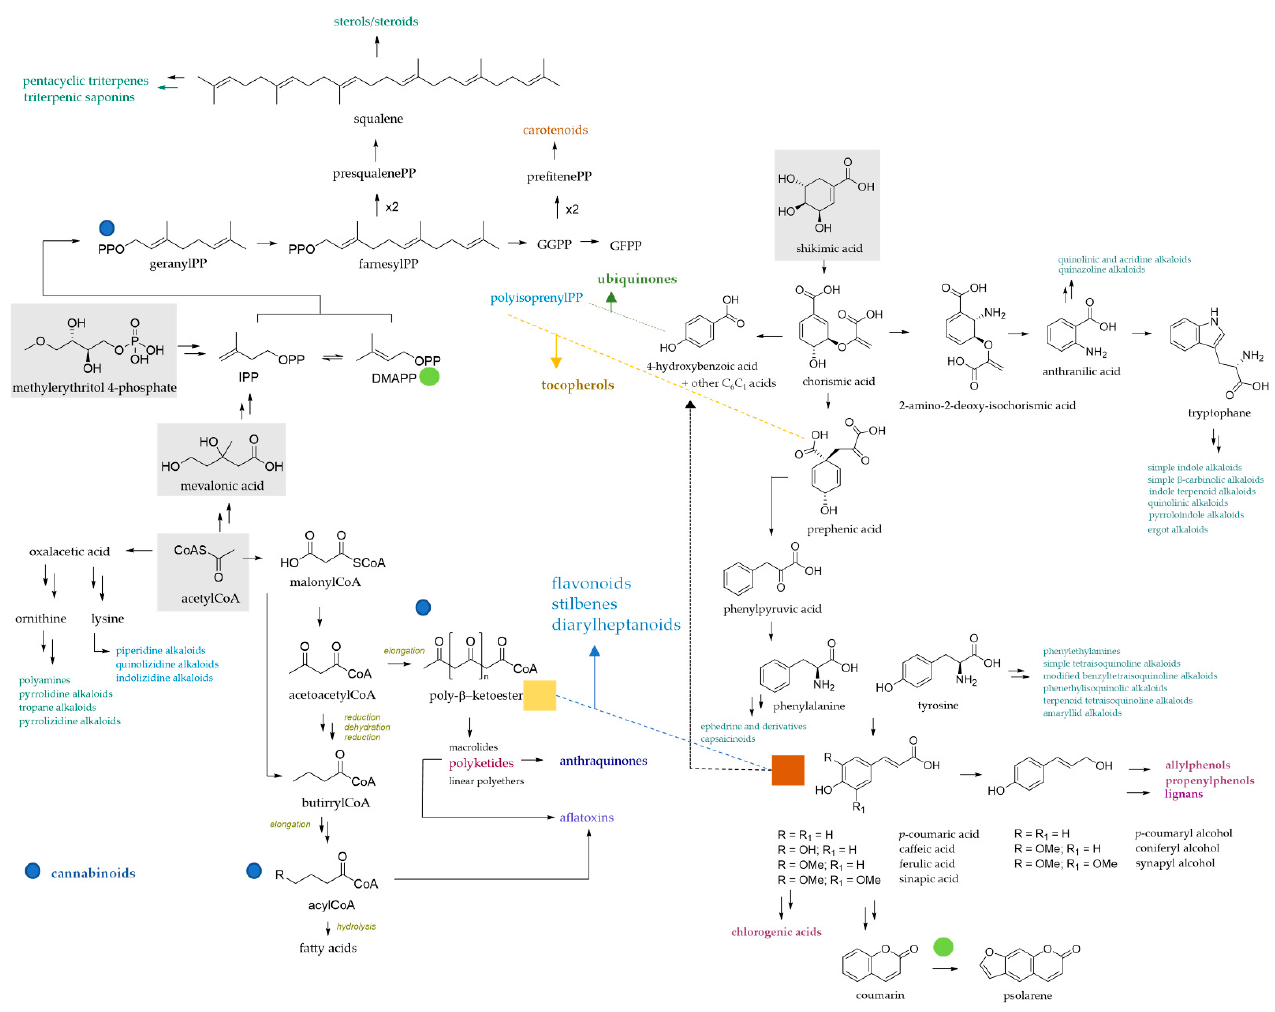
Figure 1. Schematic of the main biosynthetic pathways in plants to achieve phenols and polyphenols. Shikimic acid is the precursor of simple phenols and phenylpropanoids (hydroxycinnamic acid, coumarin lignans and lignins), which upon reacting with polyketides by acetate/malonate pathway favours the synthesis of flavonoids, stilbenes, flavolignans, and structurally related compounds. Terpenoid quinones are also produced when shikimic acid derivatives react with polyisoprenyl chains. The acetate pathway leads to fatty acid biosynthesis, by FAS enzyme, or poly- β -keto chains, which upon undergoing intramolecular reaction by polyketide synthase, leads to simple phenols, generally characterized by meta -substitution, or more complex compounds such as anthraquinones and aflatoxins. Three units of acetyl CoA combined by Claisen and aldol reactions lead to mevalonic acid, from which isopentenyl pyrophosphate (IPP) or dimethylallyl pyrophosphate (DMAPP) are synthetized. Methylerythritol 4-phosphate (MEP) is also a precursor of IPP/DMAPP. The two isoprene units are involved in the biosynthesis of terpenes, classified according to number of carbons. Essential oils (EOs), which are mixtures of low-molecular-weight terpenes, as well as triterpenic saponins, are deeply investigated for their pharmacological applications and different actions on ruminant health [9,10]. Alkaloids are biosynthesized by different precursors (the main classes from anthranilic acid, aromatic amino acids, ornithine and lysine are indicated). GGPP = geranylgeranyl diphosphate; GFPP = geranyl farnesyl diphosphate.